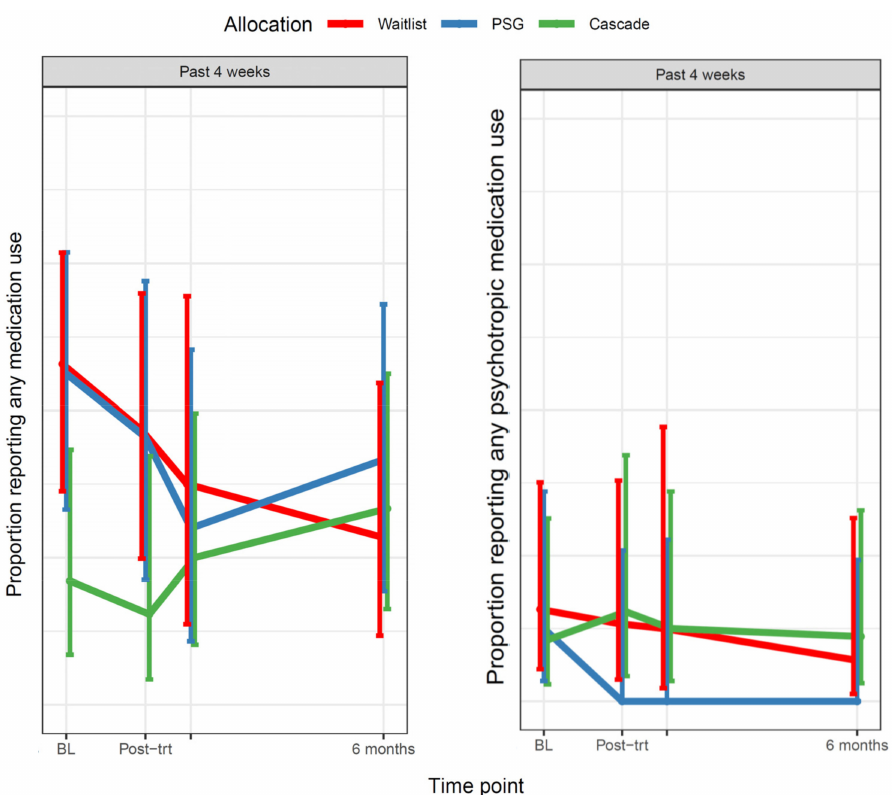
Figure 7. The proportion of parents reporting any medication use, and psychotropic medication use, in the last four weeks. Notes: Psychotropic medications included antidepressants, anxiolytics and mood stabilizers. BL: Baseline (Q1); Post-trt (Q2): After